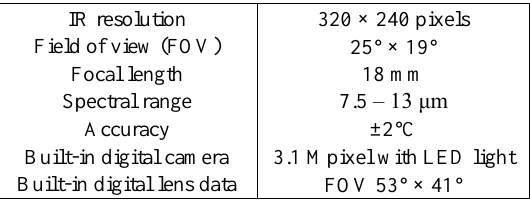
Table 1. Characteristics of the thermal camera FLIR